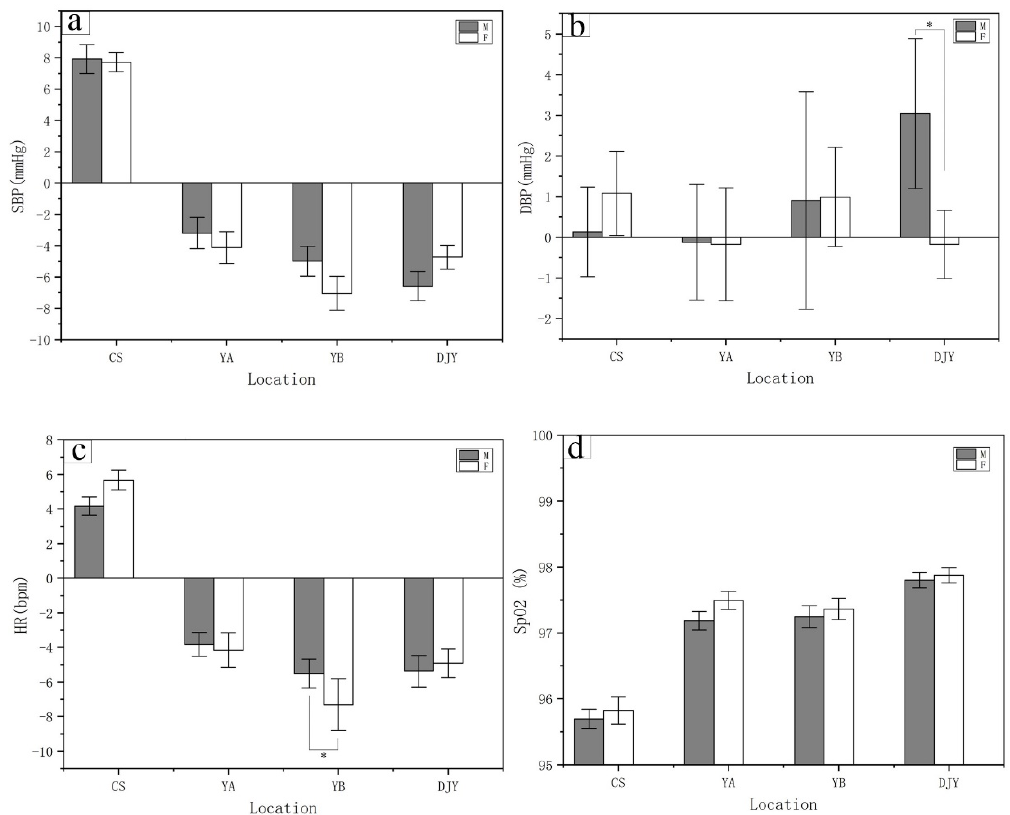
Figure 7. Changes in systolic blood pressure, diastolic blood pressure, heart rate, and peripheral oxygen saturation in participants after bamboo forest and urban program. One-way ANOVA (Turkey’s test) was used to compare the data between male and female subjects after three days of bamboo forest therapy. The data are presented as the mean ± SEs; * p < 0.05; significant di ff erence between the data for male and female subjects for the physiological indexes by paired t test. CS ( n = 30), City site; YA ( n = 30), Ya’an sites. YB ( n = 30), Yibin sites. DJY ( n = 30), Dujiangyan sites. ( a ) SBP, systolic blood pressure; ( b ) DBP, diastolic blood pressure; ( c ) HR, heart rate; ( d ) SpO2, peripheral oxygen